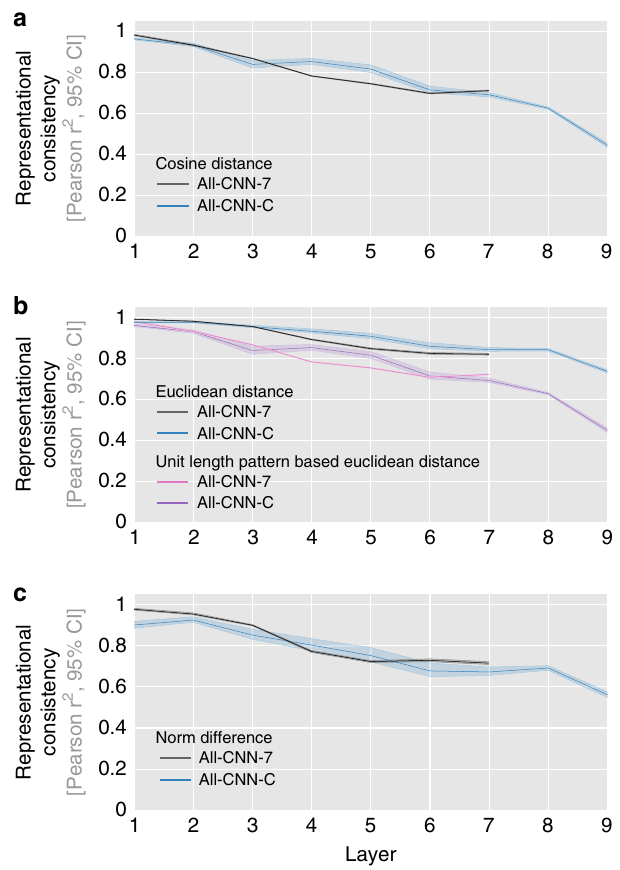
Fig. 5 Representational consistency decreases irrespective of distance measure. Representational consistency decreases with increasing layer depth for both tested DNN architectures, and across multiple ways to measure distances in multivariate population responses (cosine ( a ), Euclidean distance and unit length pattern-based Euclidean distance ( b ), and differences in vector norm ( c )). Average representational consistency shown for each layer, computed across all pairwise comparisons of network instances (45 comparisons for 10 instances), together with a 95% bootstrapped con fi dence interval.